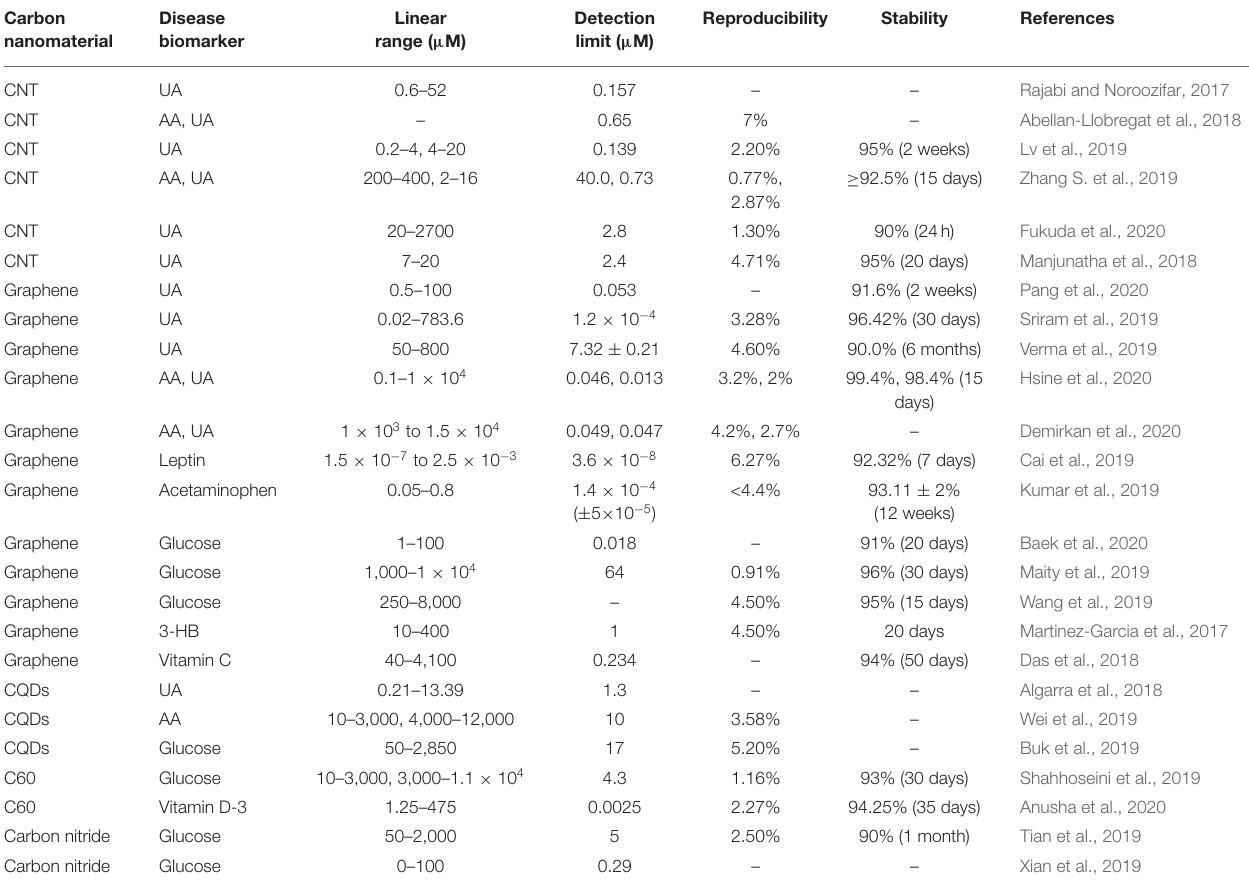
TABLE 1 | Comparison of electrochemical sensors based on carbon nanomaterials for detecting biomarkers of metabolic diseases. Carbon